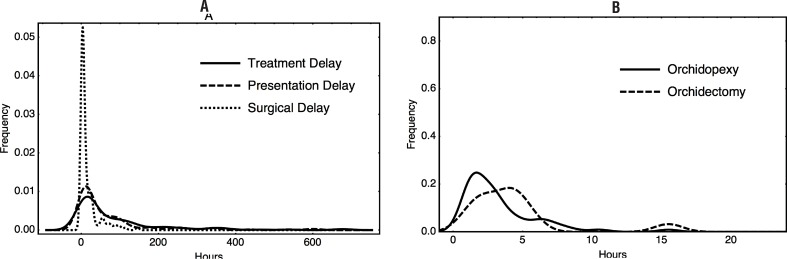
A: Distribution of treatment, presentation and surgical delay among all patients; B: Distribution of surgical delay between patients either submitted to orchidectomy or orchidopexy, with presentation delay < 24 hours